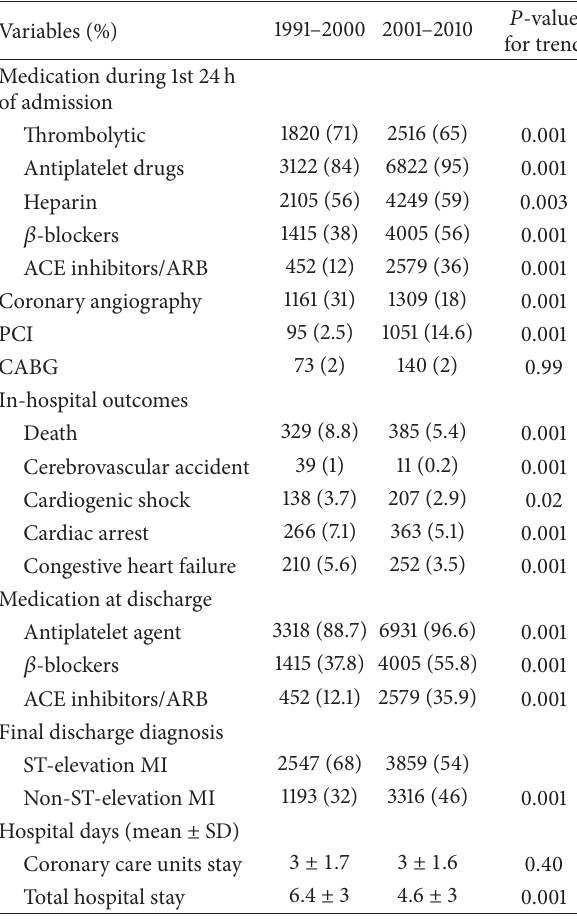
Table 2: Management and in-hospital outcomes according to study period (1991–2010).